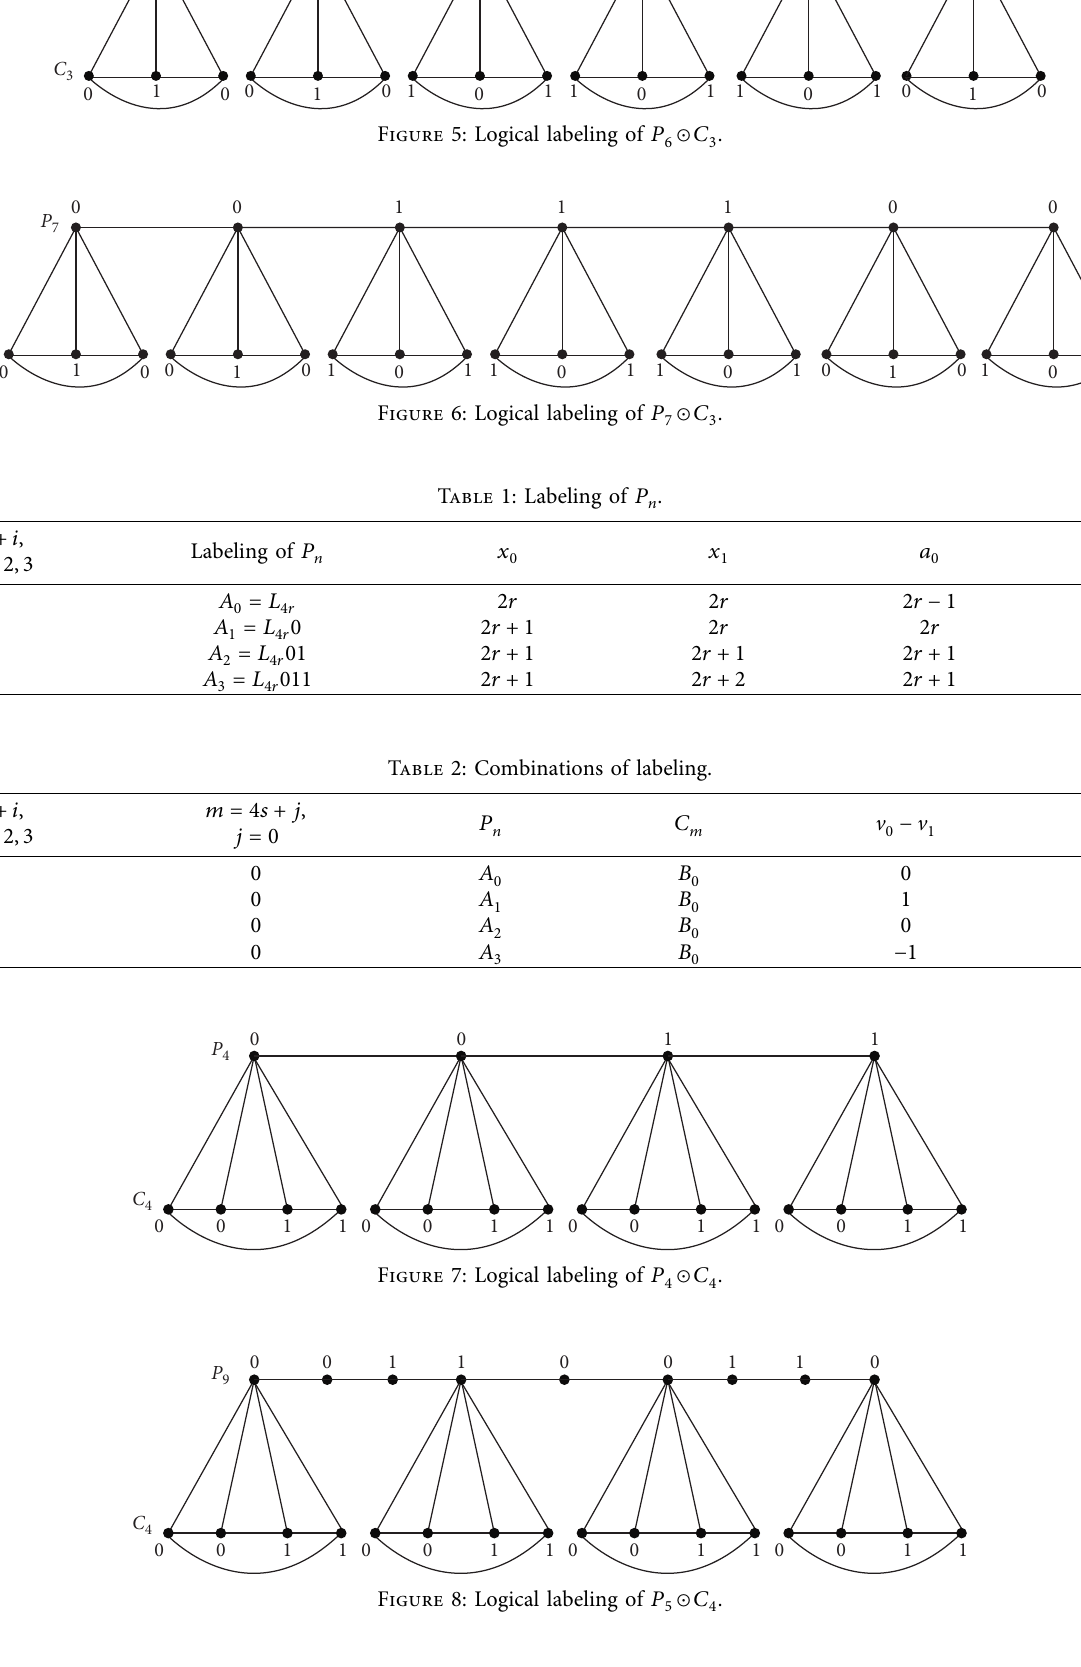
Figure 5: Logical labeling of P